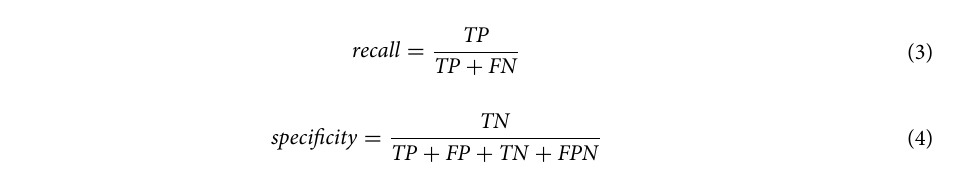
Figure 1. The validation dataset images and the P(PCTcorrect) values calculated by the fine-tuned GoogLeNet CNN. CNN, convolutional neural network; PCT, pentagon copying test; P(PCTcorrect), CNN-calculated probability of the PCT image being categorized as